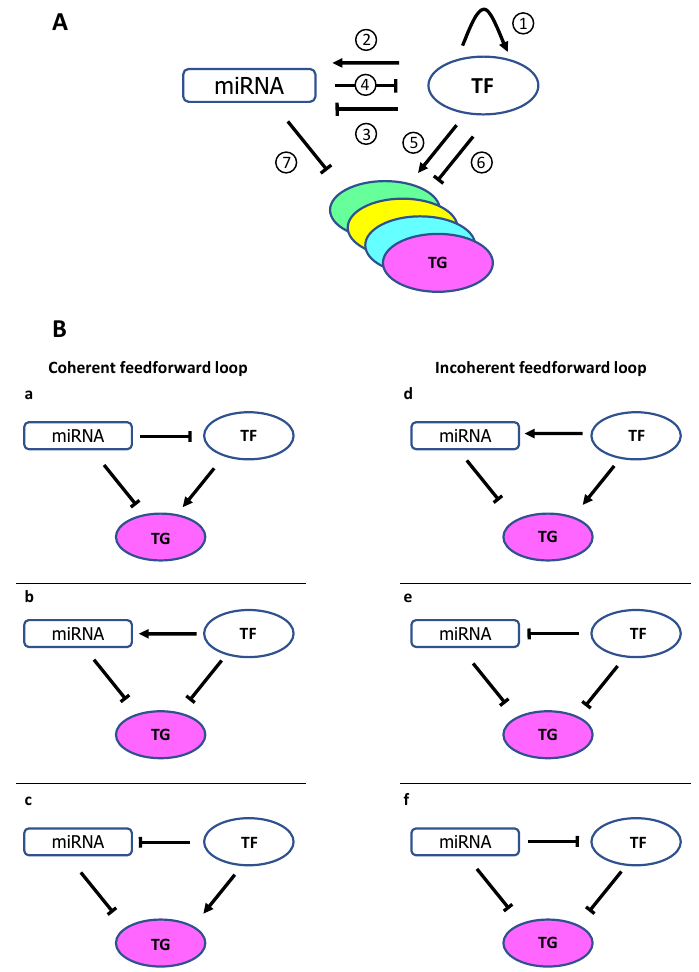
Figure 1. Schematic representation of the most common miRNA ‐ TF ‐ TG auto ‐ regulatory networks. ( A ) Seven main types of regulatory relationships are considered among TFs, miRNAs and TGs. ( 1 ) TF self ‐ transcriptional activation; ( 2 – 4 ) Direct reciprocal feedback between miRNAs and TFs; ( 5 , 6 ) A TF can activate or repress the TG transcription; ( 4 , 7 ) A miRNA can simultaneously suppress the TF and many of its targets. ( B ) Common miRNA–TF–TG auto ‐ regulatory network motifs. Left side ( a – c ): Coherent feedforward loops, in which a TF and miRNA regulate a TG in a complementary direction (either activating or repressing). Right side ( d – f ): Incoherent feedforward, in which the TFs and miRNAs have opposing (buffering) effects. By physical interaction through 3 ′ UTR mRNA binding, miRNAs can regulate TFs and down ‐ modulate entire functional units to establish and maintain cell phenotype [61]. Many gene sets are reciprocally regulated by strongly interacting pairs of TF ‐ miRNA forming feed forward loops with their common TGs to efficiently suppress functionally related proteins.